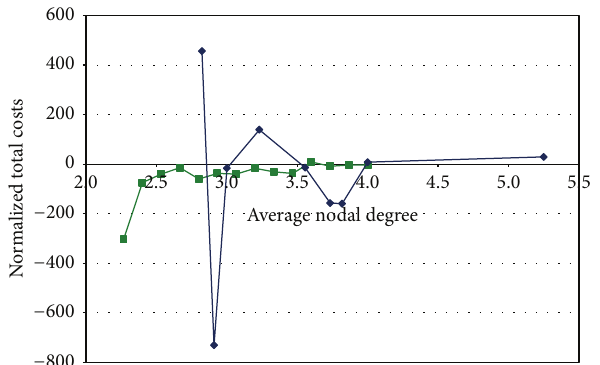
Figure 16: Slope of path restoration SCA normalized spare capacity cost.